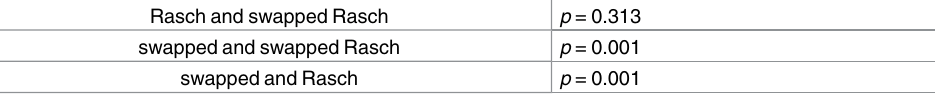
Table 1. p -values for Kolmogorov-Smirnov tests between the pairs of distributions. Significance threshold is